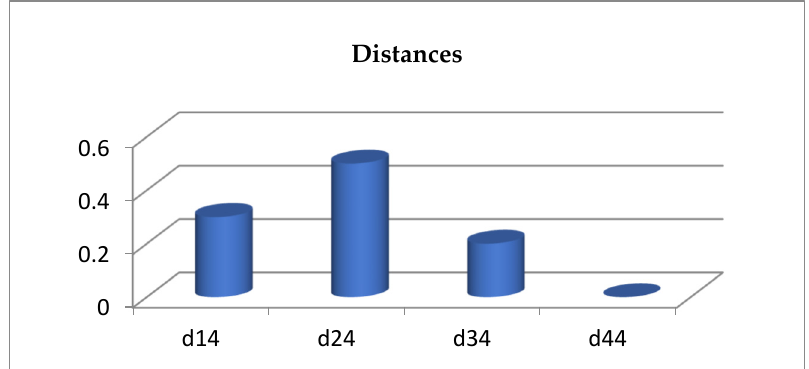
Figure 2. Distances from the 4th point of the SVNS A .